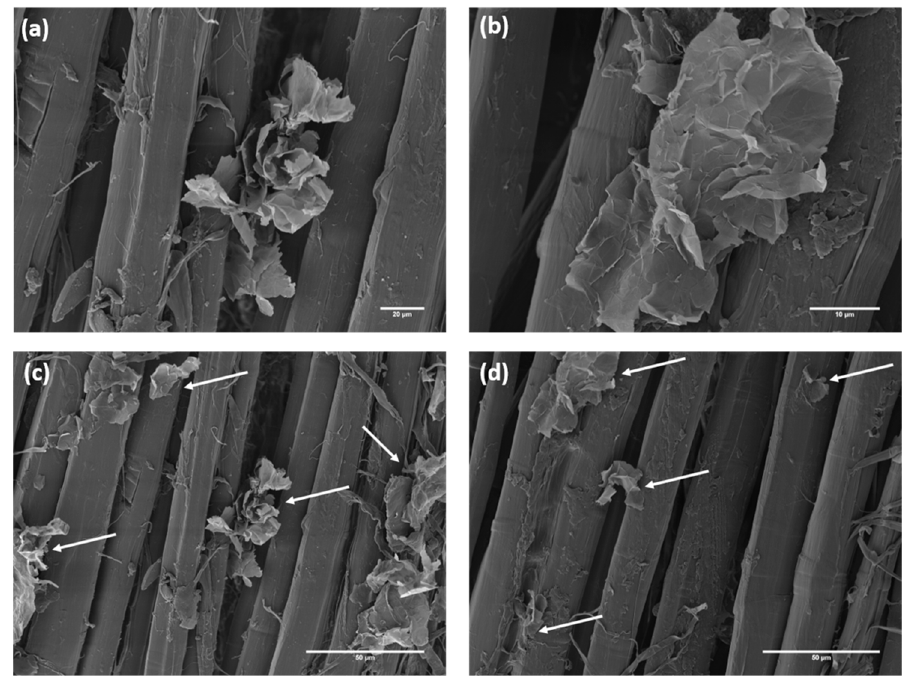
Figure 3. SEM micrographs showing the flax fabrics decorated with graphene nanoplatelets (GNPs) at different magnifications .